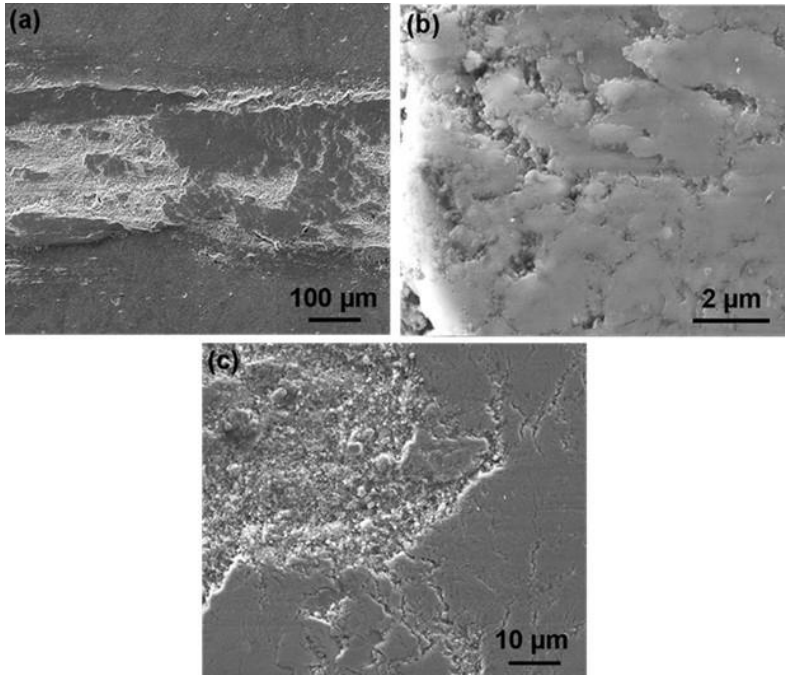
Figure 10. SEM images (secondary electron imaging mode) of the wear track on TiAlN/VN generated at 550 °C. ( a ) low magnification ( b ) high magnification image of the smeared wear debris ( c ) partly fragmented oxide.